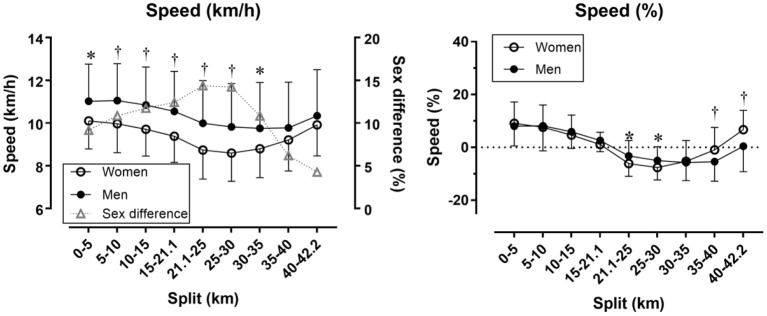
Race speed in absolute (left) and relative values (right) by sex and split. Error bars represent standard deviations; * and †depict statistical difference between women and men at p < 0.05 and p < 0.01, respectively. Speed (%) has been calculated as percentage difference of split speed and average race speed.